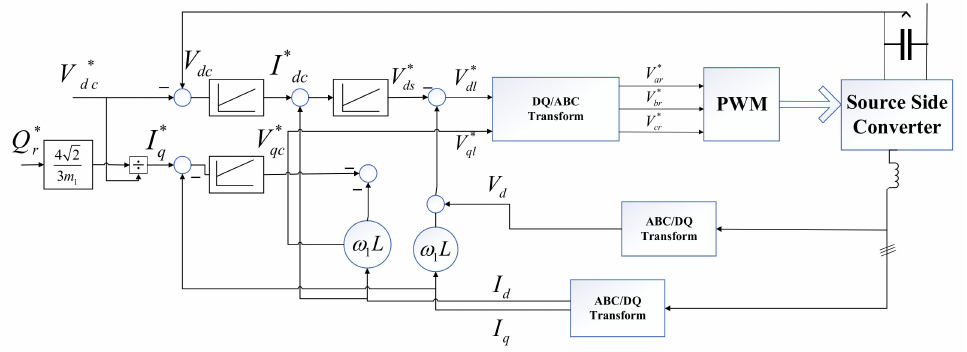
Figure 8. Overall control framework of the DFIG. Table 5. The parameters of the DFIG. WTG